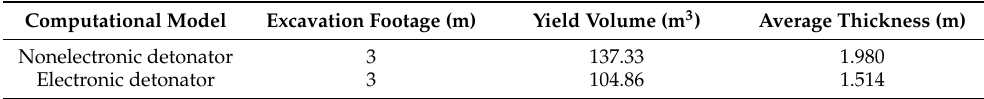
Table 4. The average thickness of the loose ring calculated by simulation.